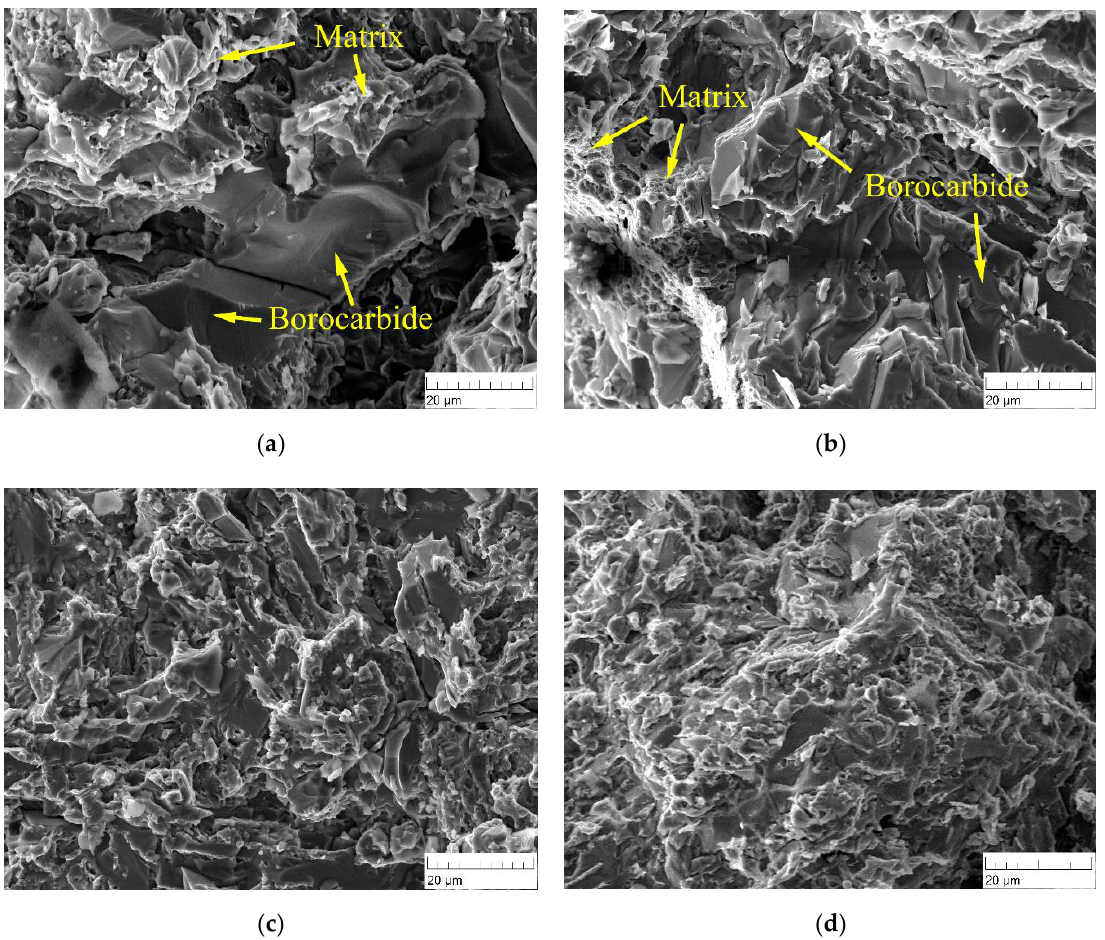
Figure 12. Fractures of high-boron multi-component alloy with various titanium contents: ( a ) M, 0.0 wt.%, ( b ) T1, 0.2 wt.%, ( c ) T2, 0.4 wt.%, ( d ) T3, 0.6 wt.%.